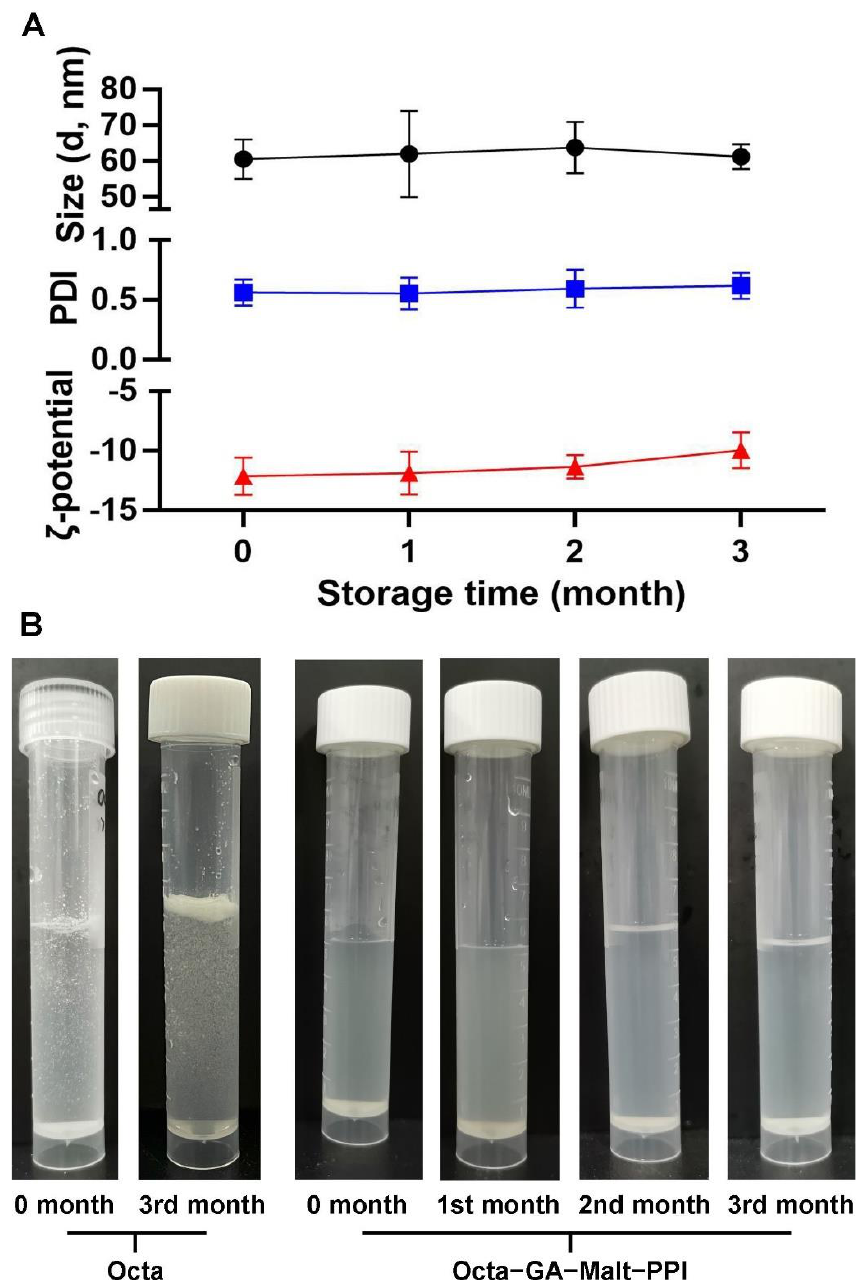
Figure 3. Effect of different storage times on the stability of Octa − GA − Malt − PPI microcapsule. ( A ) ζ − potential, PDI, and particle size. ( B ) The images of the Octa monomer and Octa − GA − Malt − PPI microcapsule during the 3 − month storage